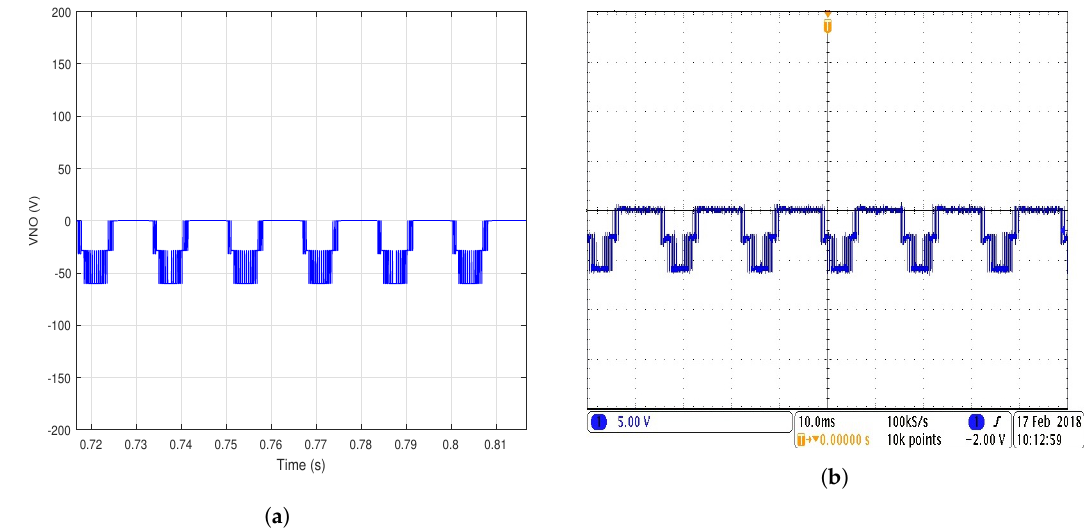
Figure 10. Results of five-level SS MLI: ( a ) simulated V NO voltage; ( b ) experimental V NO voltage.